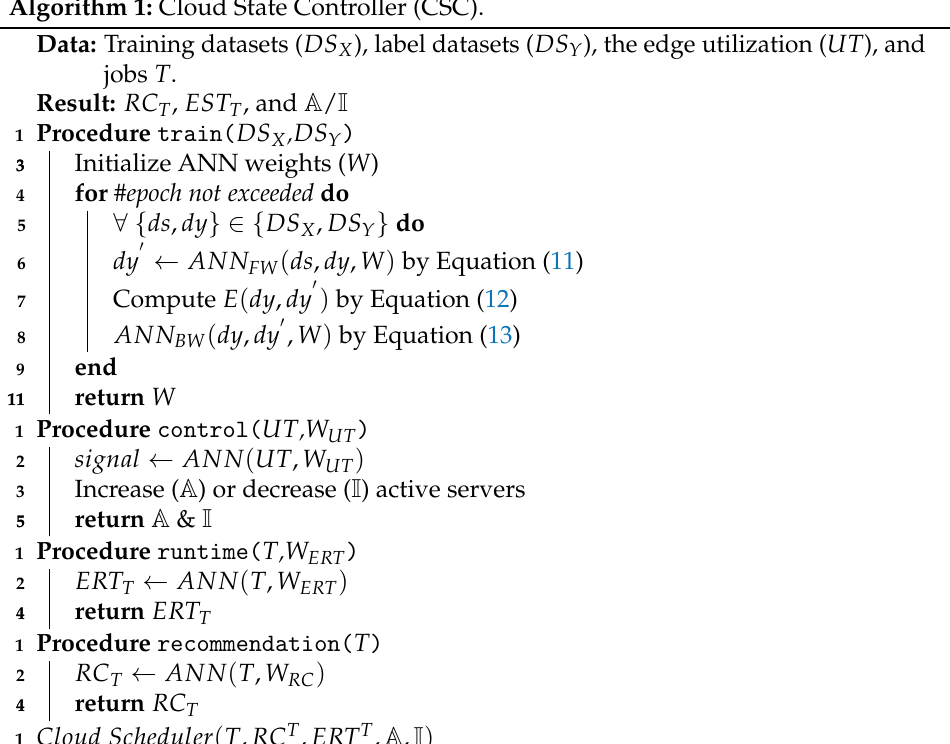
Algorithm 1: Cloud State Controller